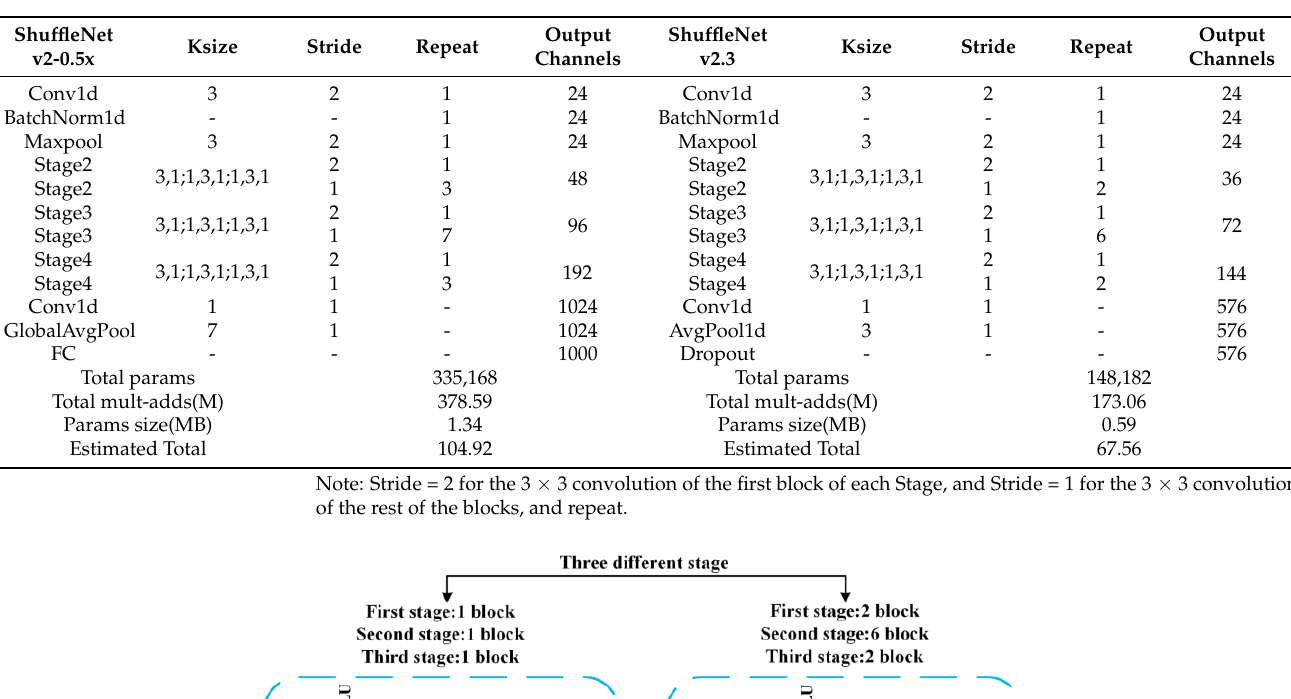
Table 1. Comparison of ShuffleNet v2-0.5x and ShuffleNet v2.3 parameters.